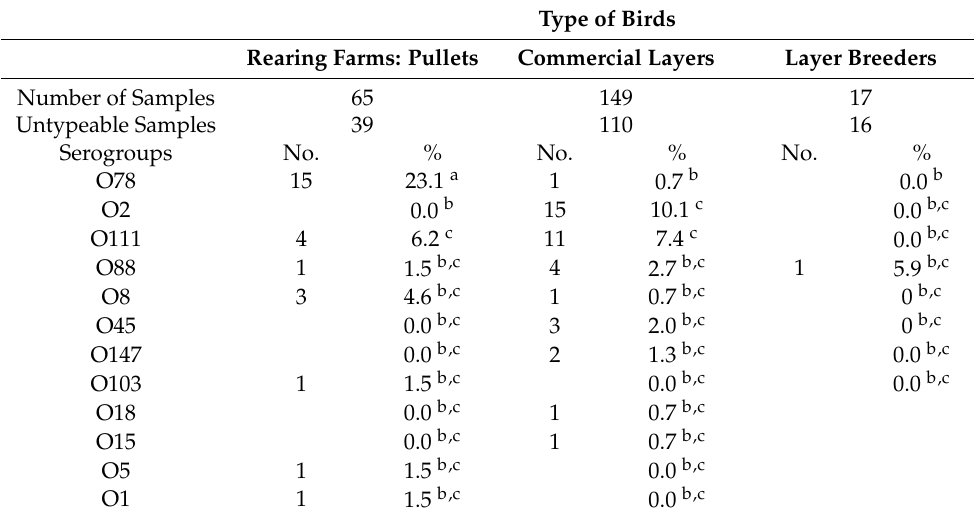
Table 3. Distribution of E. coli strains according to type of